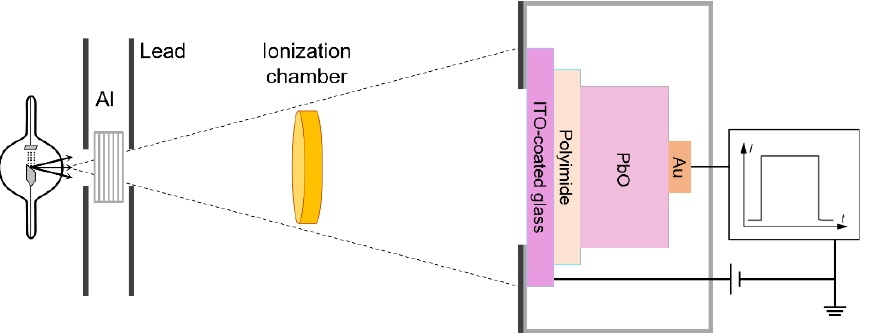
Figure 2. Schematic representation of the X-ray induced photocurrent method (XPM) used in this work for the characterization of the X-ray response performance of detector prototypes (not to scale) [23].